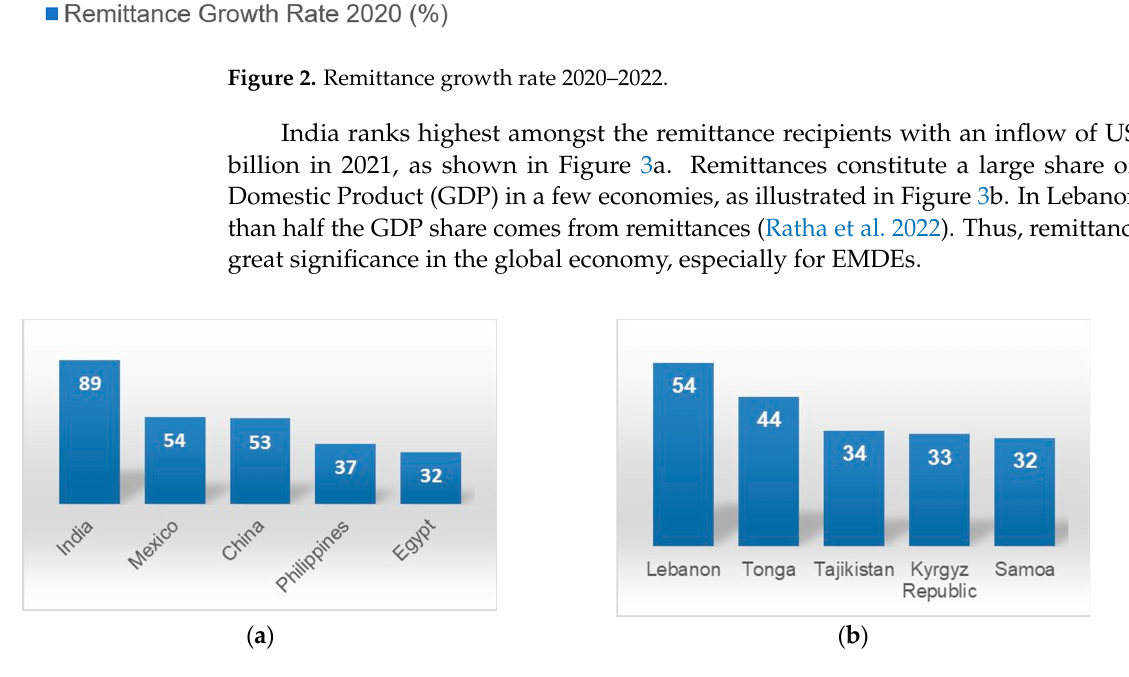
Figure 3. Top remittance inflows, 2021 ( a ) in current USD ( b ) as a share of GDP.